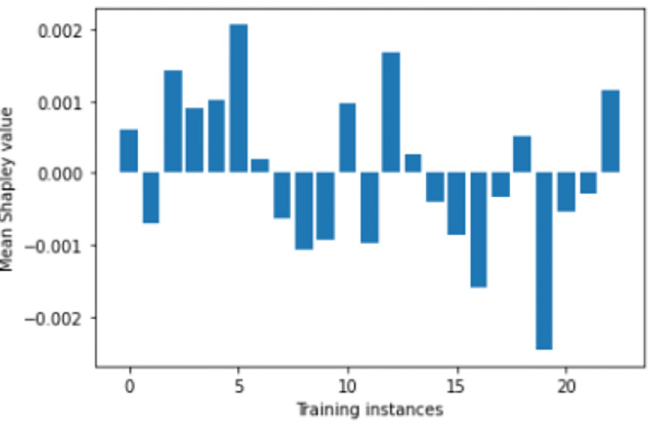
Fig 5. Estimation of input attribution for “ECGFivedays”